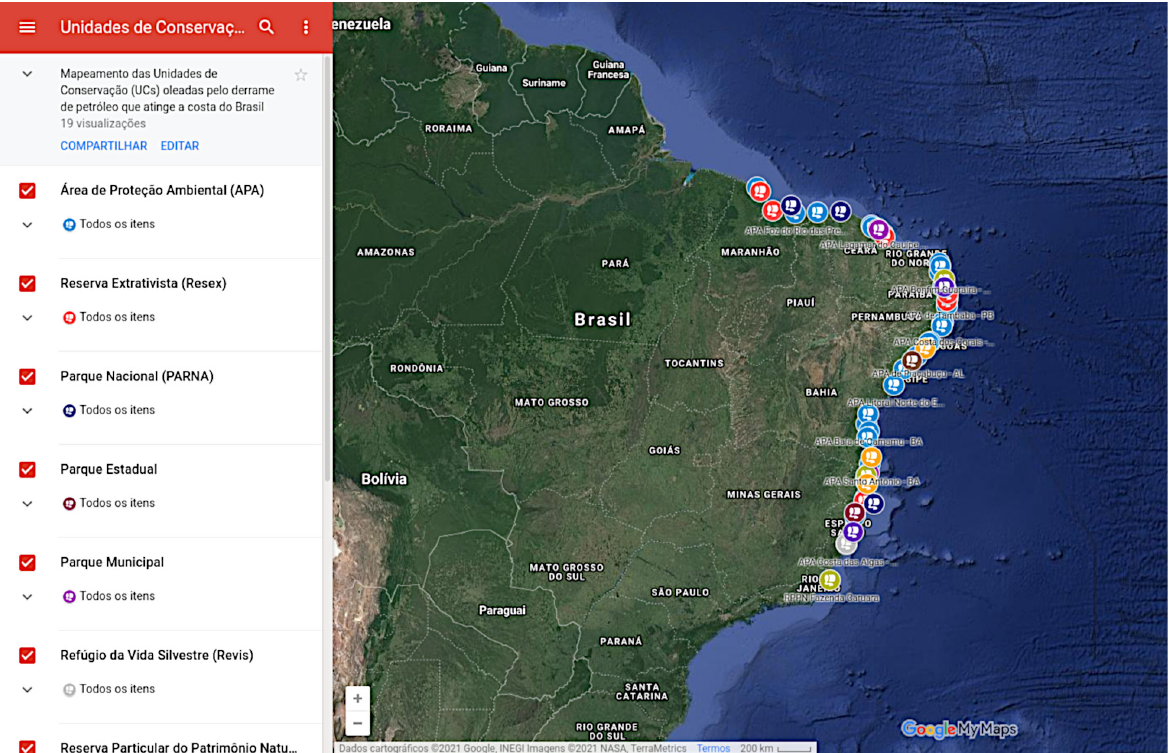
Figure 5. Online interactive map with the Nature Conservation Units affected by the Brazilian oil spill. Available at: